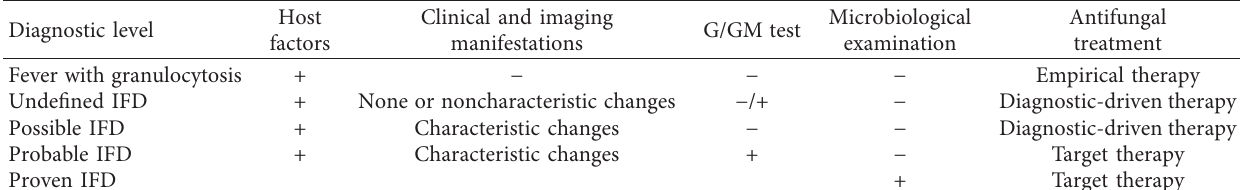
Table 1: The criteria of IFD and antifungal treatment strategies in the Chinese